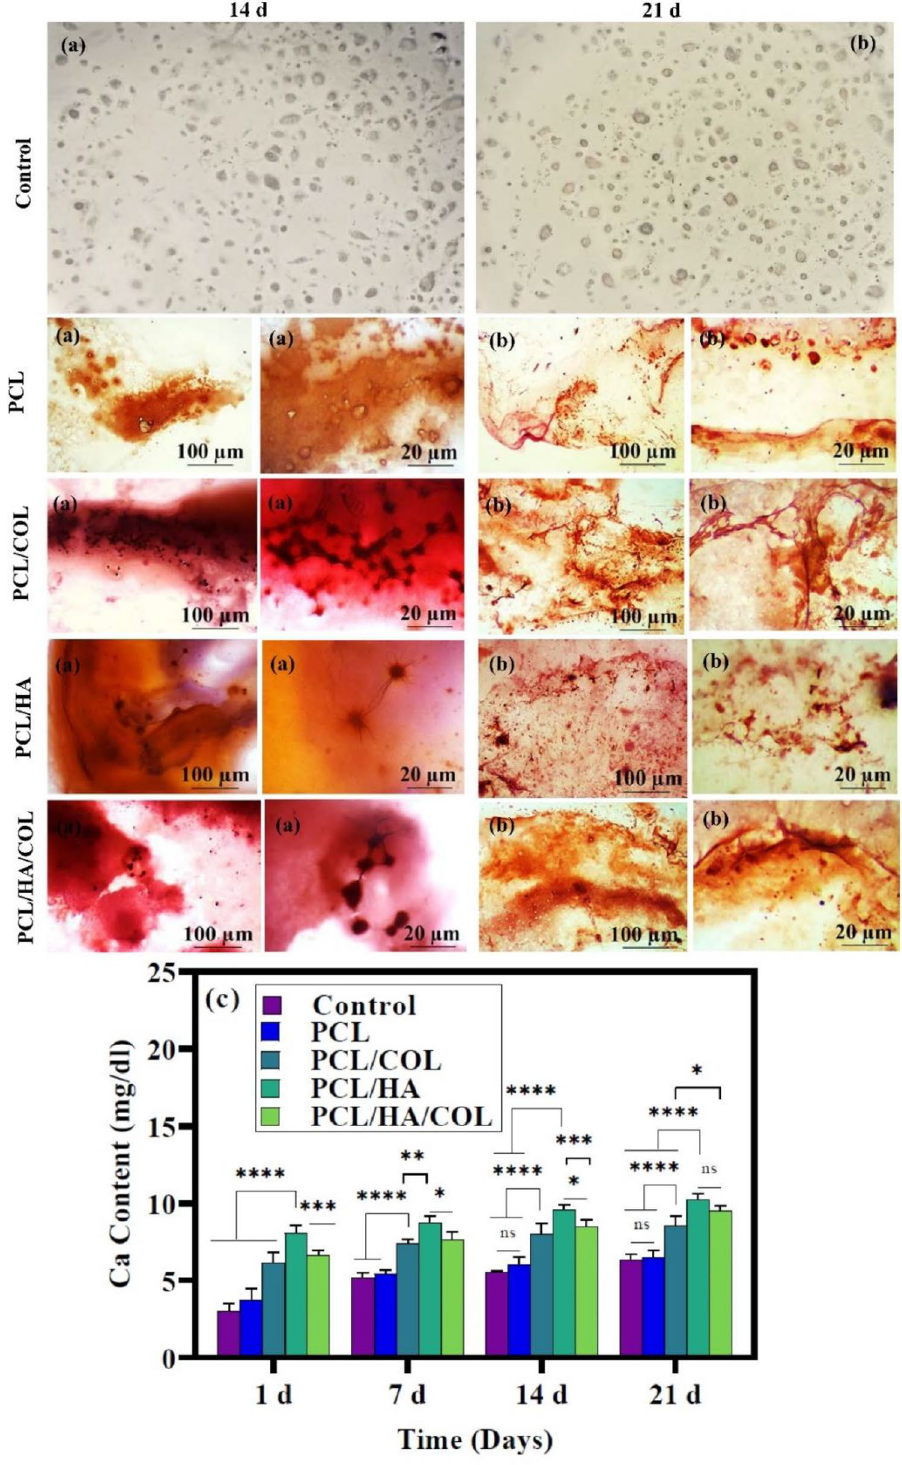
Figure 5. Bone mineralization capacity. In the following image, ( a ) Alizarin Red staining after a 14 days’ culture. ( b ) After 21 days, Alizarin Red staining. After 21 days of culture, more staining was observed (Scale bar = 100 μm and 20 μm). ( c ) Calcium concentration of hADSCs on the scaffolds measured after 1,714 and 21 days’ culture (n = 3, ***p ≤